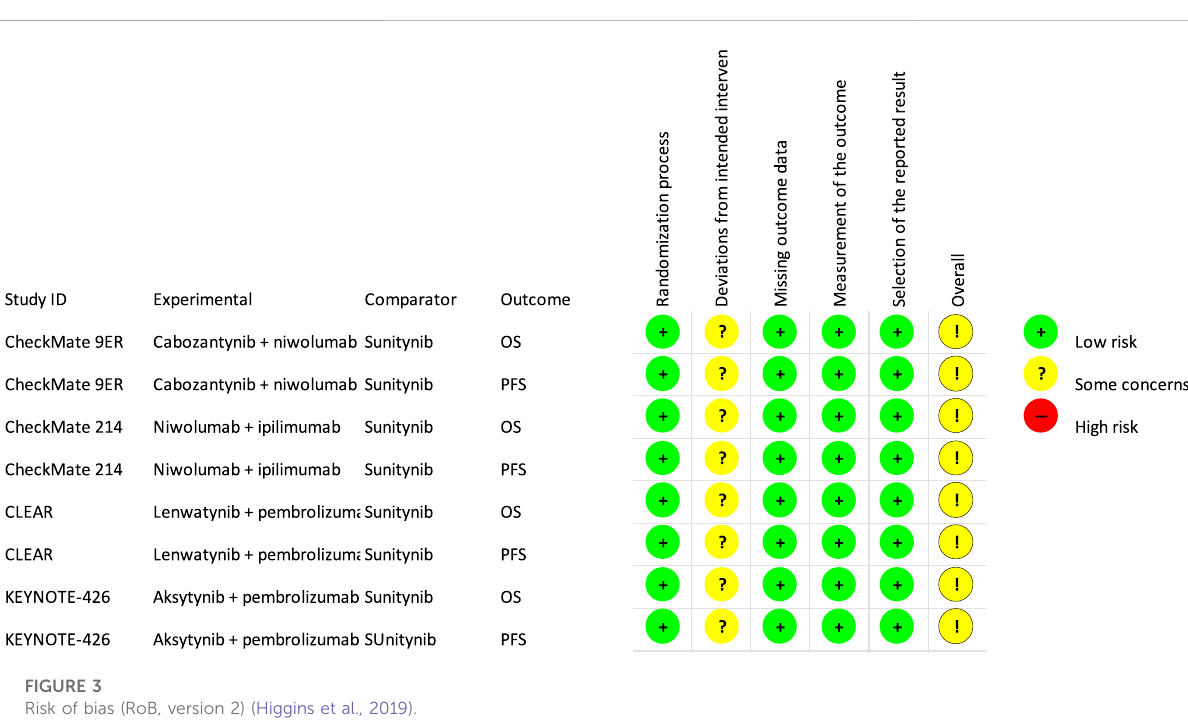
TABLE 1 Hazard ratios (HR) for overall survival in the overall population.